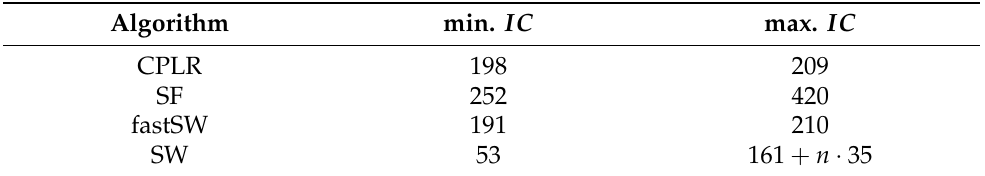
Table 2. Instruction counts ( IC ) of 4D implementations of CPLR, SF, fastSW, and SW on an ARM Cortex-M4 microcontroller, with n denoting the length of the current